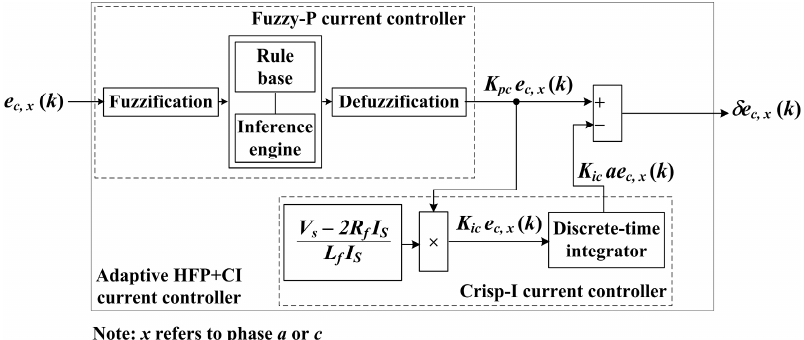
Figure 3. Block diagram of the proposed hybrid controller.